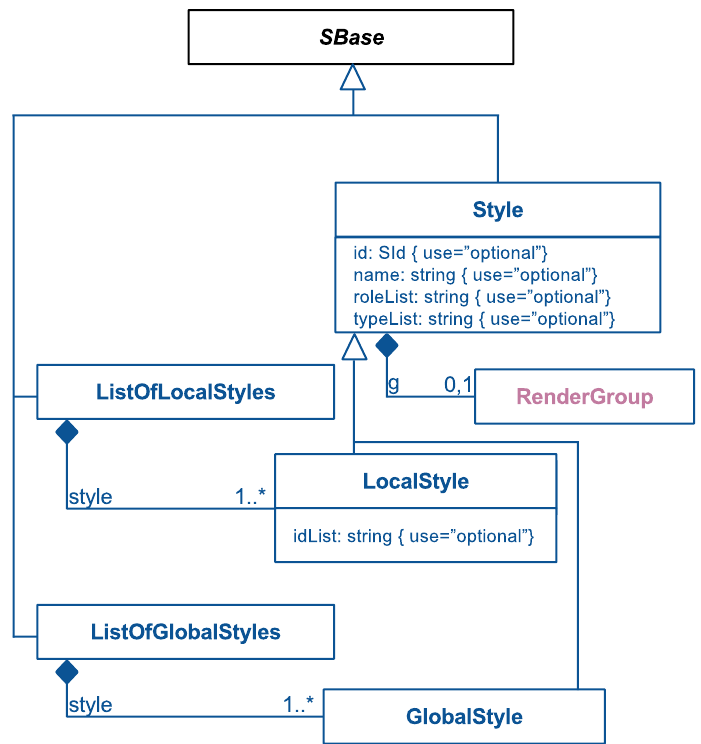
Figure 5: A UML representation of the Style object for the Render package. See Section 1.4 for conventions related to this figure.